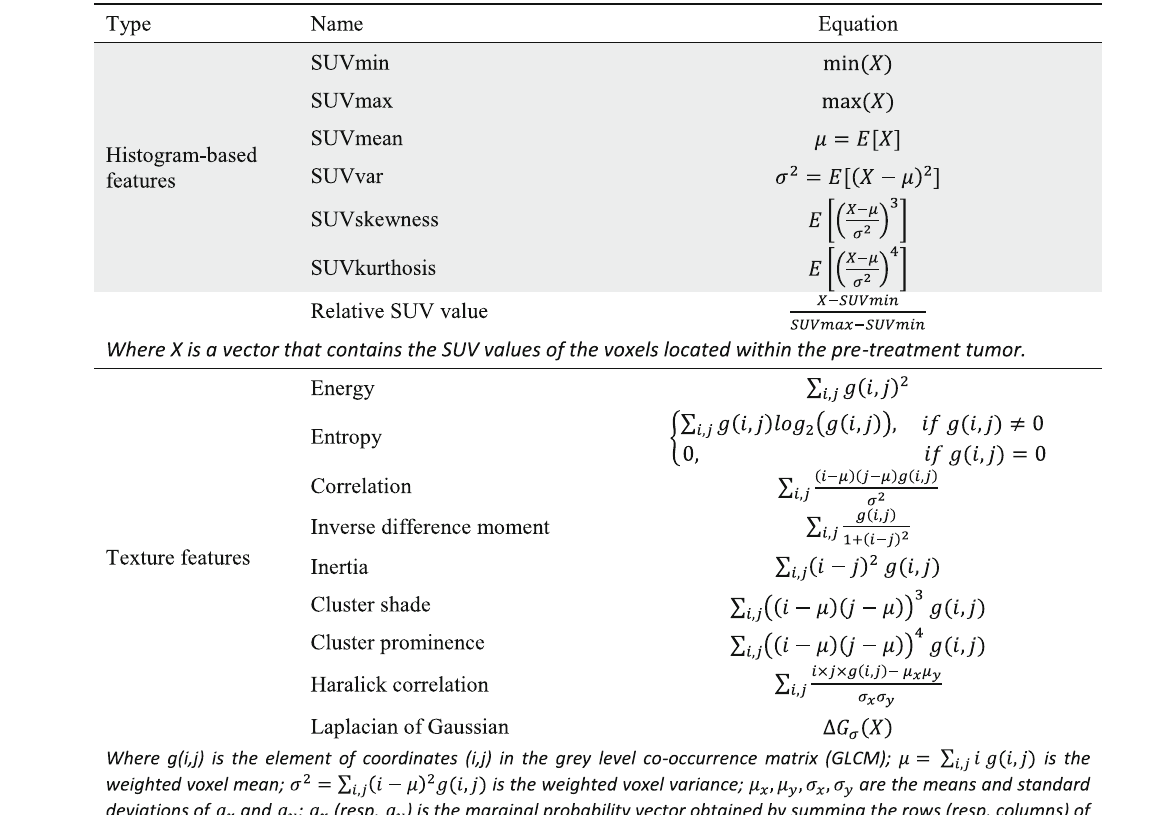
Table 1 Equations of radiomics features used to characterize the recurrence volume (grey background) and to train the random